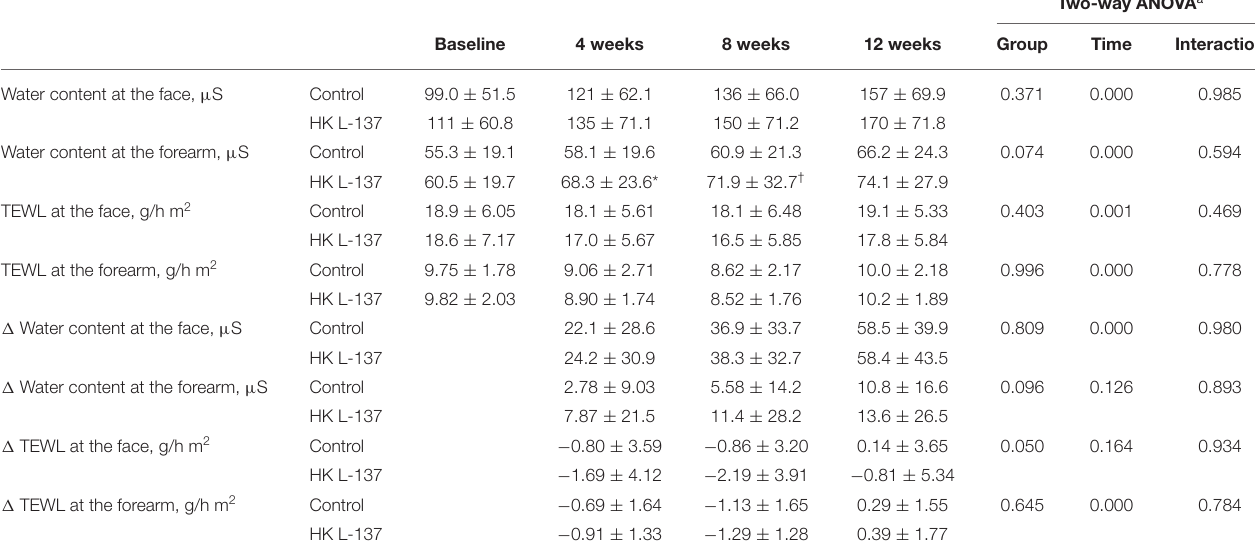
TABLE 2 | Effects of heat-killed Lactiplantibacillus plantarum L-137 on the water content of the stratum corneum and transepidermal water loss of the